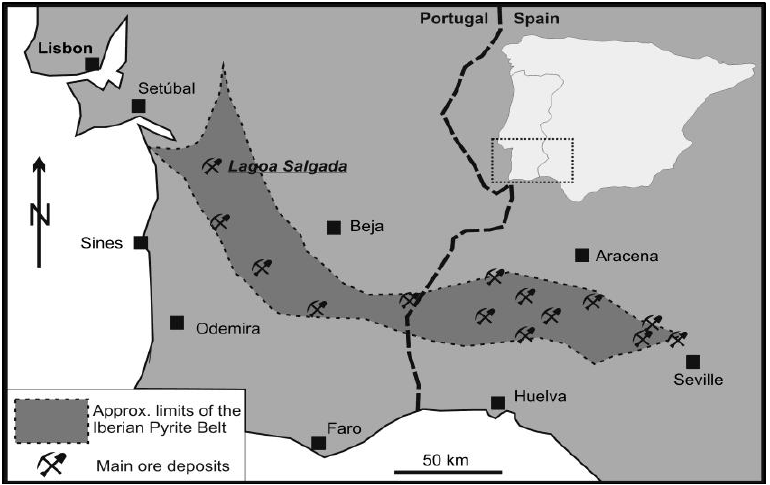
Figure 1. Location of the Lagoa Salgada orebody in the Iberian Pyrite Belt